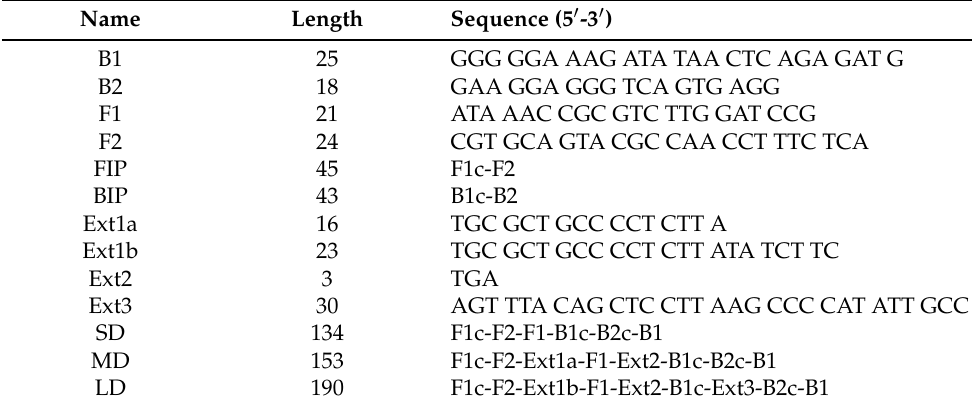
Table 1. Oligonucleotide sequences and dumbbell